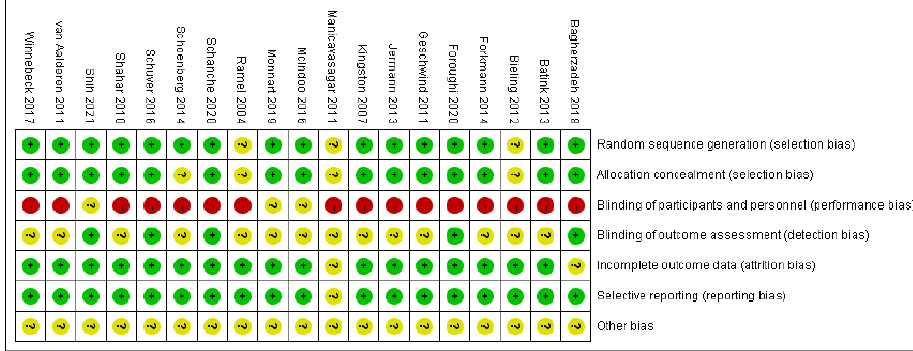
Figure 2. Risk of bias of individual studies [30–48].